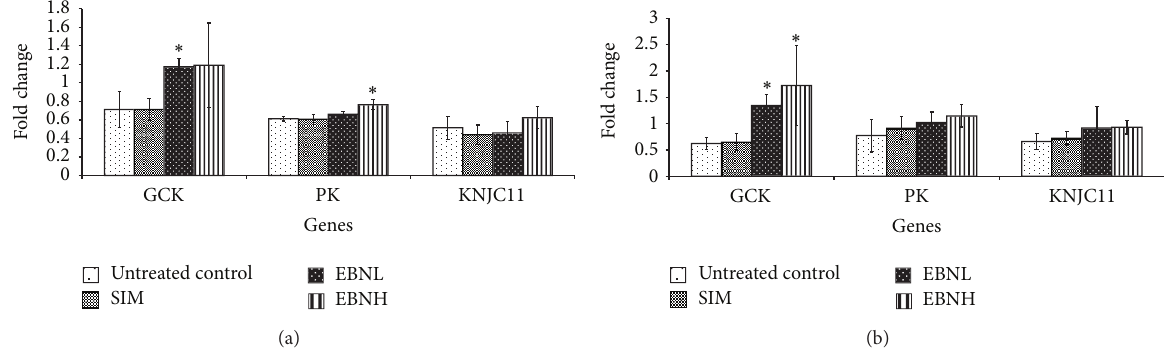
Figure 7: Effects of edible bird’s nest (EBN) on (a) hepatic and (b) adipose tissue mRNA levels of Glucokinase (Gck), potassium inwardly rectifying channel, subfamily J, member 11 (KCNJ11), and pyruvate kinase-liver isoform (L-Pk) in high fat diet- (HFD-) fed rats. Groupings are similar to Figure 2. ∗ indicates significant difference ( 𝑃 < 0.05 ) in comparison with untreated control.